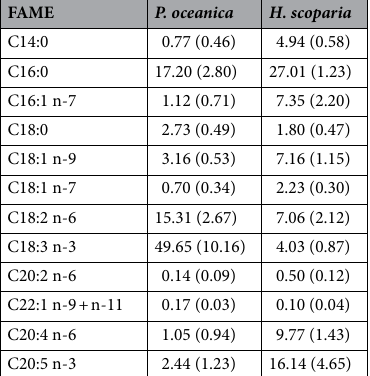
Table 1. Fatty acid profiles (annual mean values, % with SD) of P. oceanica and H. scoparia